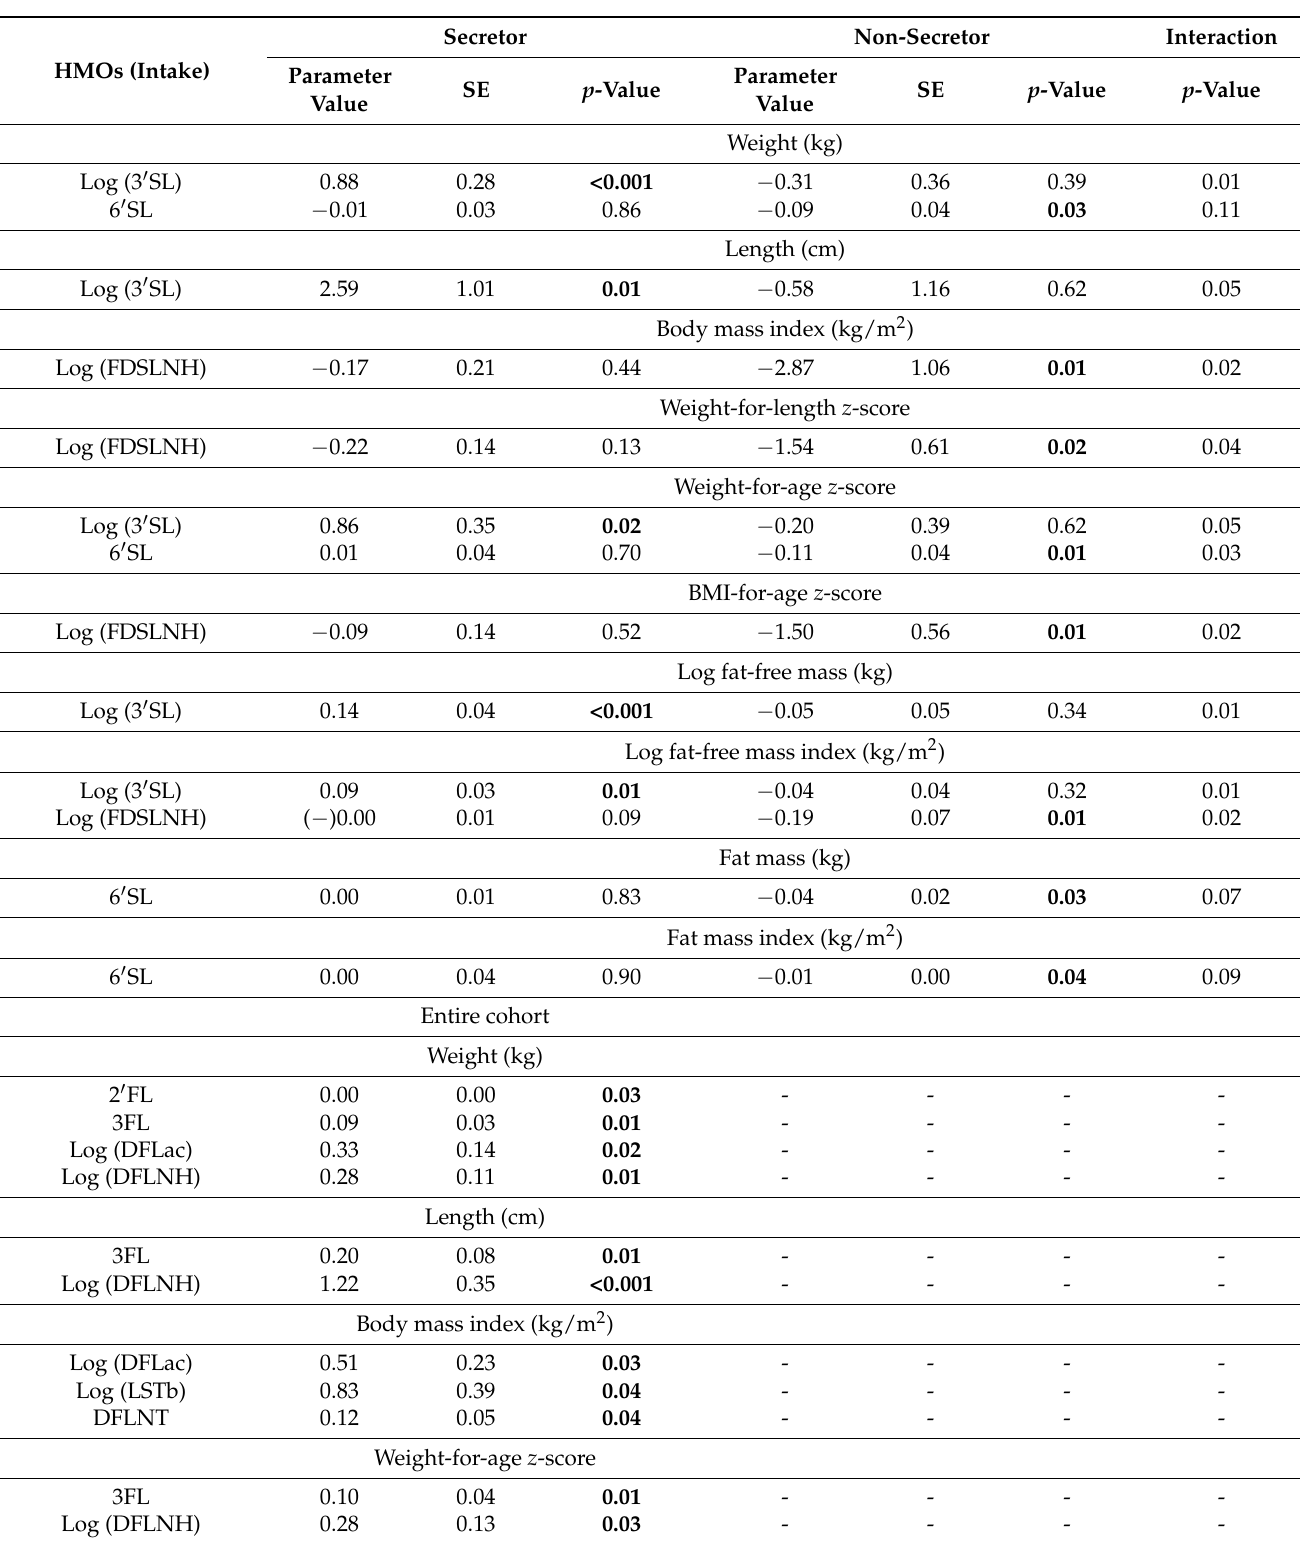
Table 7. Associations between individual HMO intake and infant body composition at three months